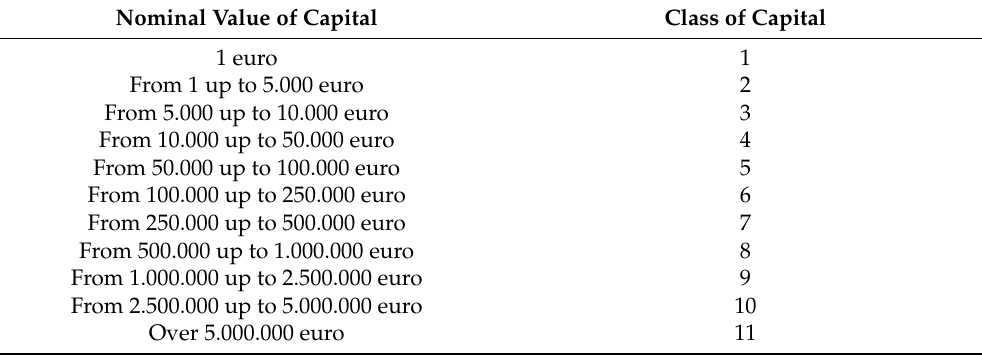
Table A4. Shows the class of Italians startups’ nominal value of capital.